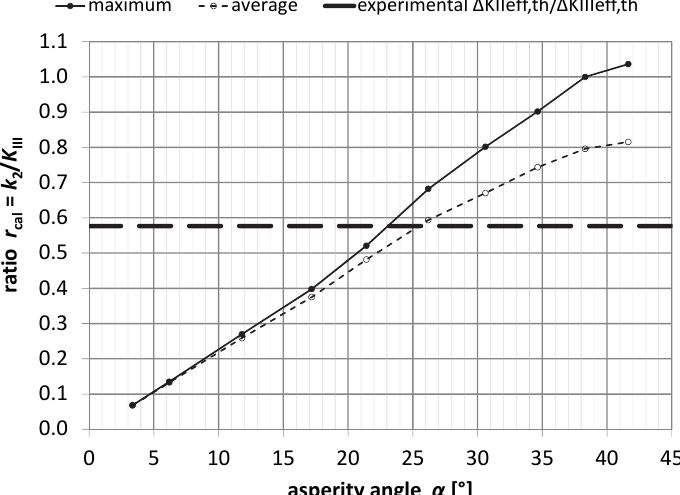
Figure 5: Dependences of r cal,max and r cal,av on the asperity angle α calculated for the respective points of the maximal value (stress concentration at point 3 in Fig. 3) and of the averaged value of the ratio r cal along the half tooth (points 2 to 8). The horizontal dashed line represents the experimental ratio of effective thresholds Δ K IIeff,th / Δ K IIIeff,th